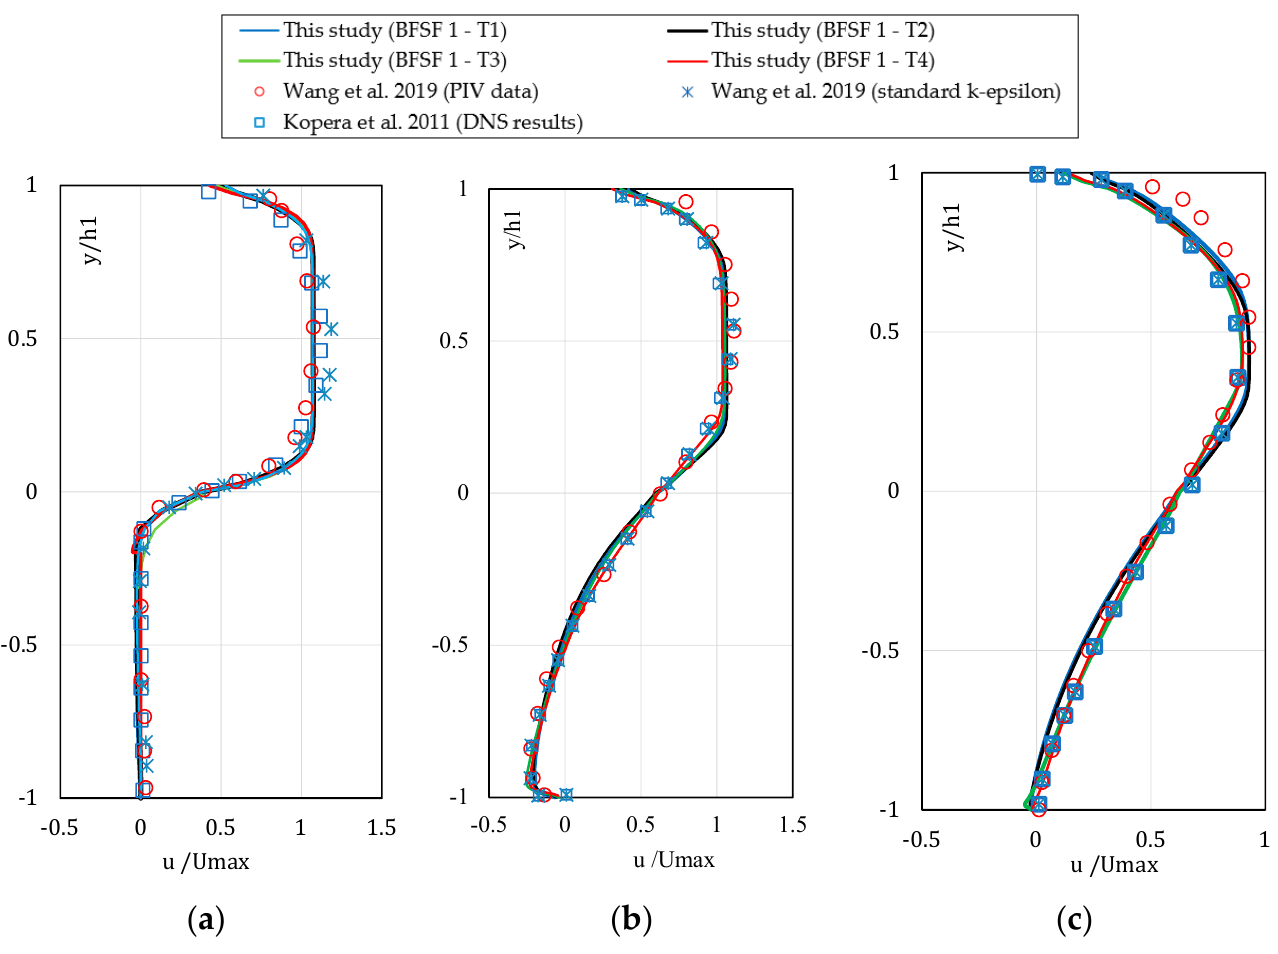
Figure 10. Dimensionless u-velocity (u/U max ) vertical profiles at ( a ) x/Lr 1 = 0.06, ( b ) x/Lr 1 = 0.46, ( c ) x/Lr 1 = 0.93, [1,30].